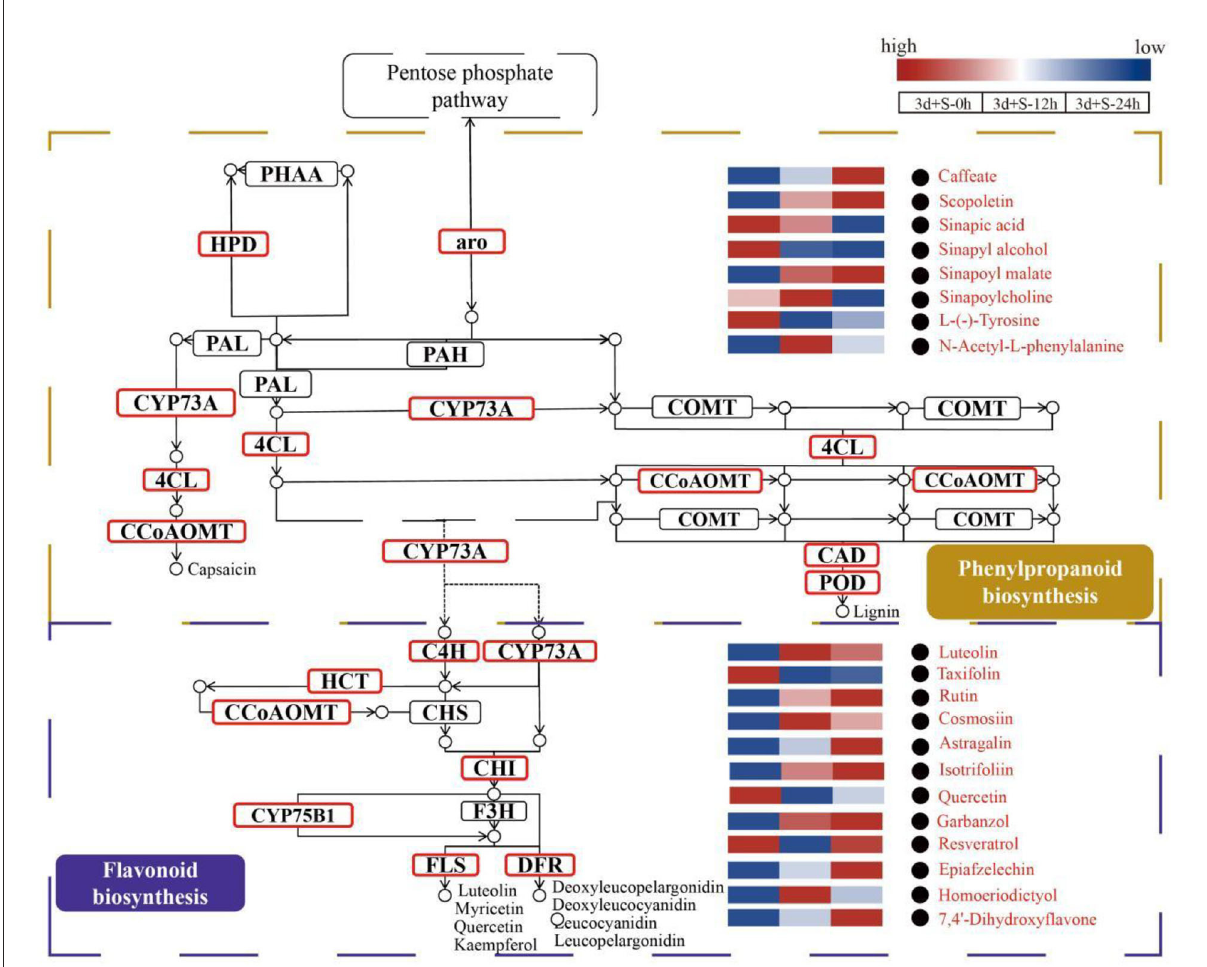
FIGURE5 The enriched pathways analyzed by metabolomics and transcriptomics. The brown box represents the phenylpropanoid biosynthesis pathway, while the purple box represents the flavonoid biosynthesis pathway. The modules with red borders are differentially expressed genes (DEGs) enriched modules, while the red words with black circles are differentially altered metabolites (DAMs). Blue to red color represents expression from low to